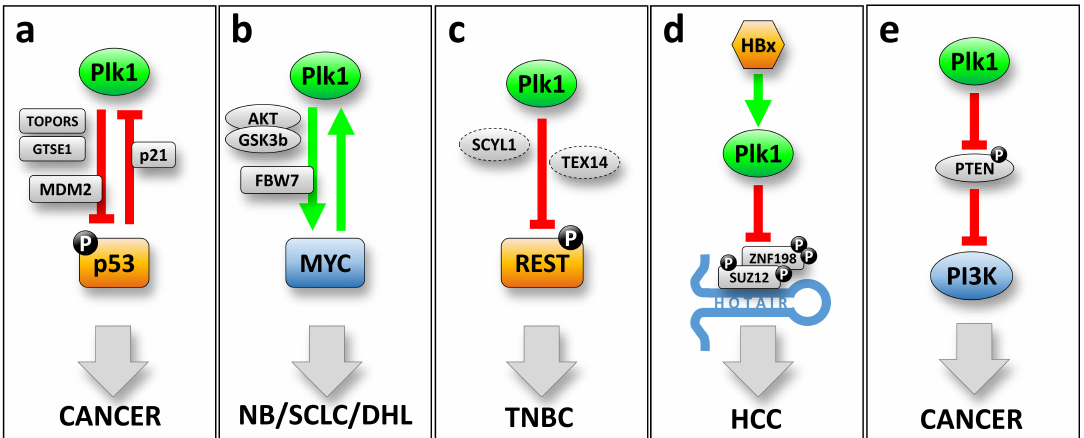
Figure 1. Proposed oncogenic mechanisms for Plk1. ( a ) The Plk1-p53 negative feedback loop. Plk1 leads to p53 destabilization, directly by phosphorylation of p53 or MDM2, or indirectly mediated by Topors and/or GTSE1. Transcriptionally, p53 is able to repress Plk1 expression directly binding to its promoter region. ( b ) The Plk1-MYC positive feedback loop. Plk1 can stabilize and increase the levels of the oncogenic transcription factor MYC, directly inhibiting the SCFFbw7 ubiquitin ligase complex, or by activation of the AKT-GSK3 β kinase circuit. These mechanisms have been described for neuroblastoma (NB), small cell lung carcinoma (SCLC) and double hit lymphoma (DHL). ( c ) Plk1 overexpression leads to degradation of the tumor suppressor REST in triple negative breast cancer (TNBC). ( d ) Plk1 activation by the hepatitis B virus HBx factor leads to degradation of the transcription repression factors SUZ12 and ZNF198, both associated with the lncRNA HOTAIR in hepatocellular carcinoma. ( e ) Plk1 can activate the oncogenic PI3K pathway by inhibiting the PTEN tumor suppressor phosphatase. This leads to an increased cell proliferation rate and an elevated Warburg